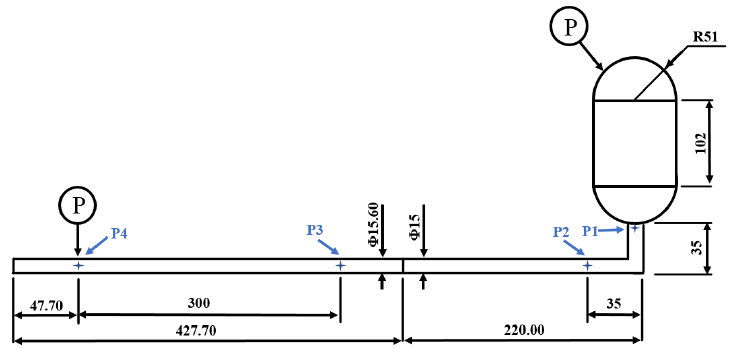
Figure 3. Diagram of the experimental device.